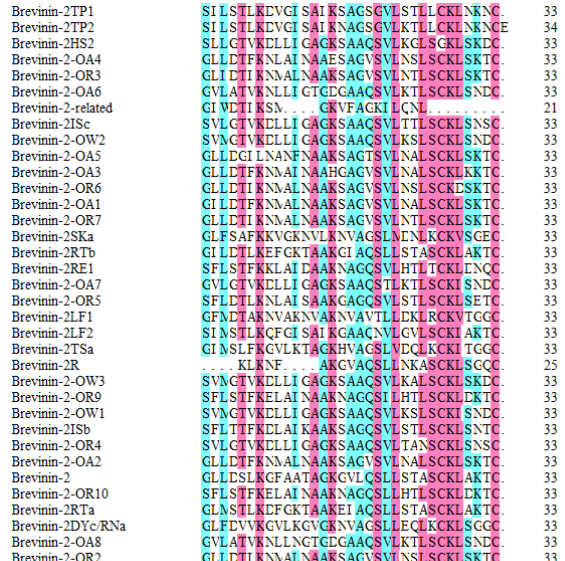
Figure 1. Multiple sequence alignment of Brevinin-2 family peptides effective against gram positive bacteria (G + ). The sequence marked in red indicates similarity to the corresponding peptide named in the far left column. The sequence marked in blue indicates an even higher similarity to the same peptide. The column on the far right shows the amino acid number of each antimicrobial peptide.